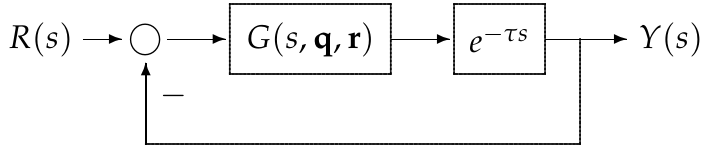
Figure 1. Closed-loop system for the interval plant with time-delay.